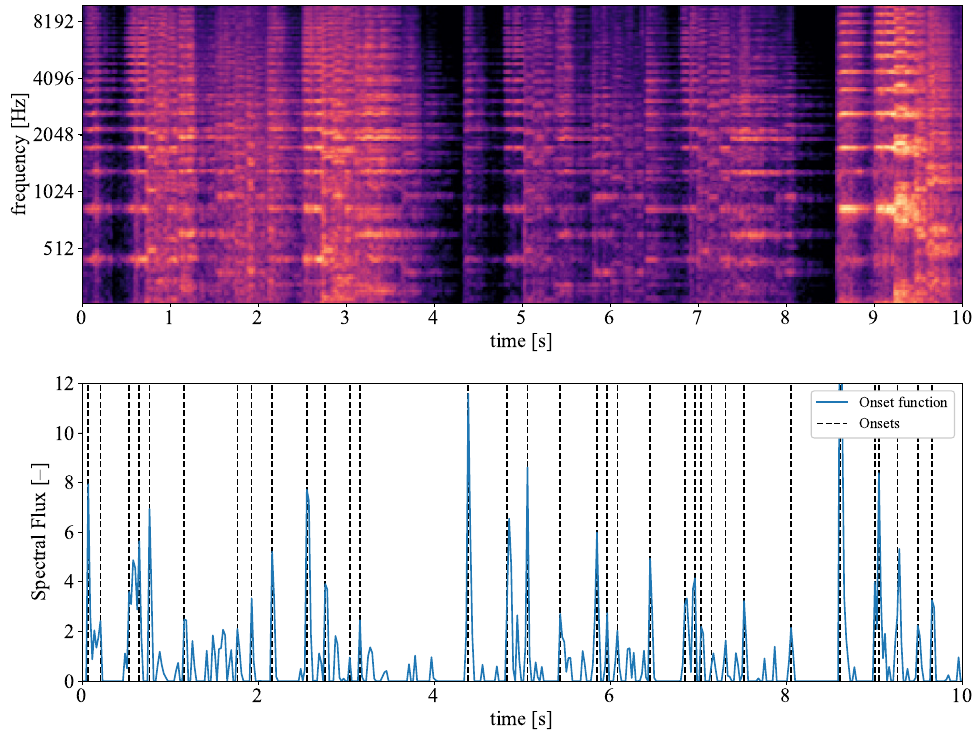
Figure 7. Spectrogram and onset detection function for a solo violin using